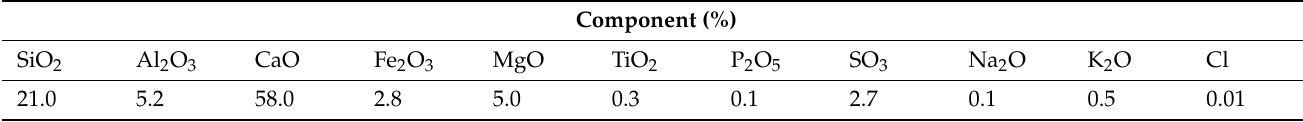
Table 2. Chemical composition of the